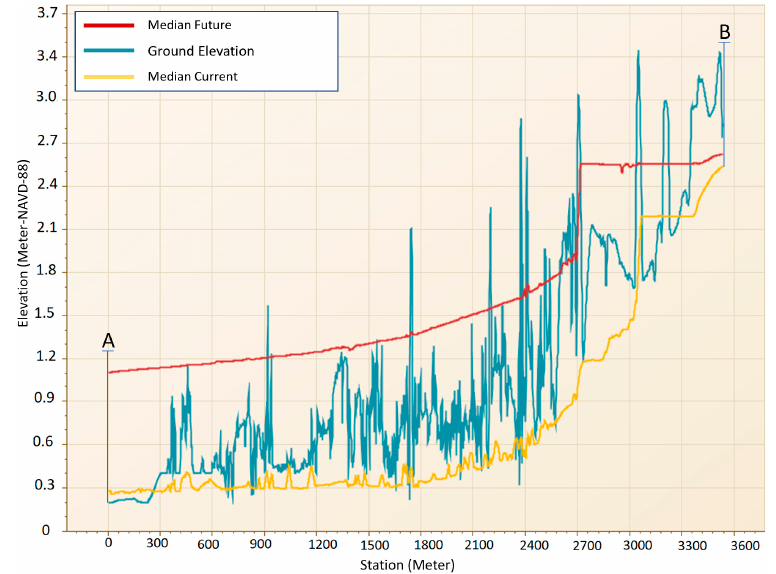
Figure 8. Comparison of ground surface elevation and median current and future groundwater profiles along the primary outflow path in the study area. B and A represent the start and end of the primary outflow path, respectively.